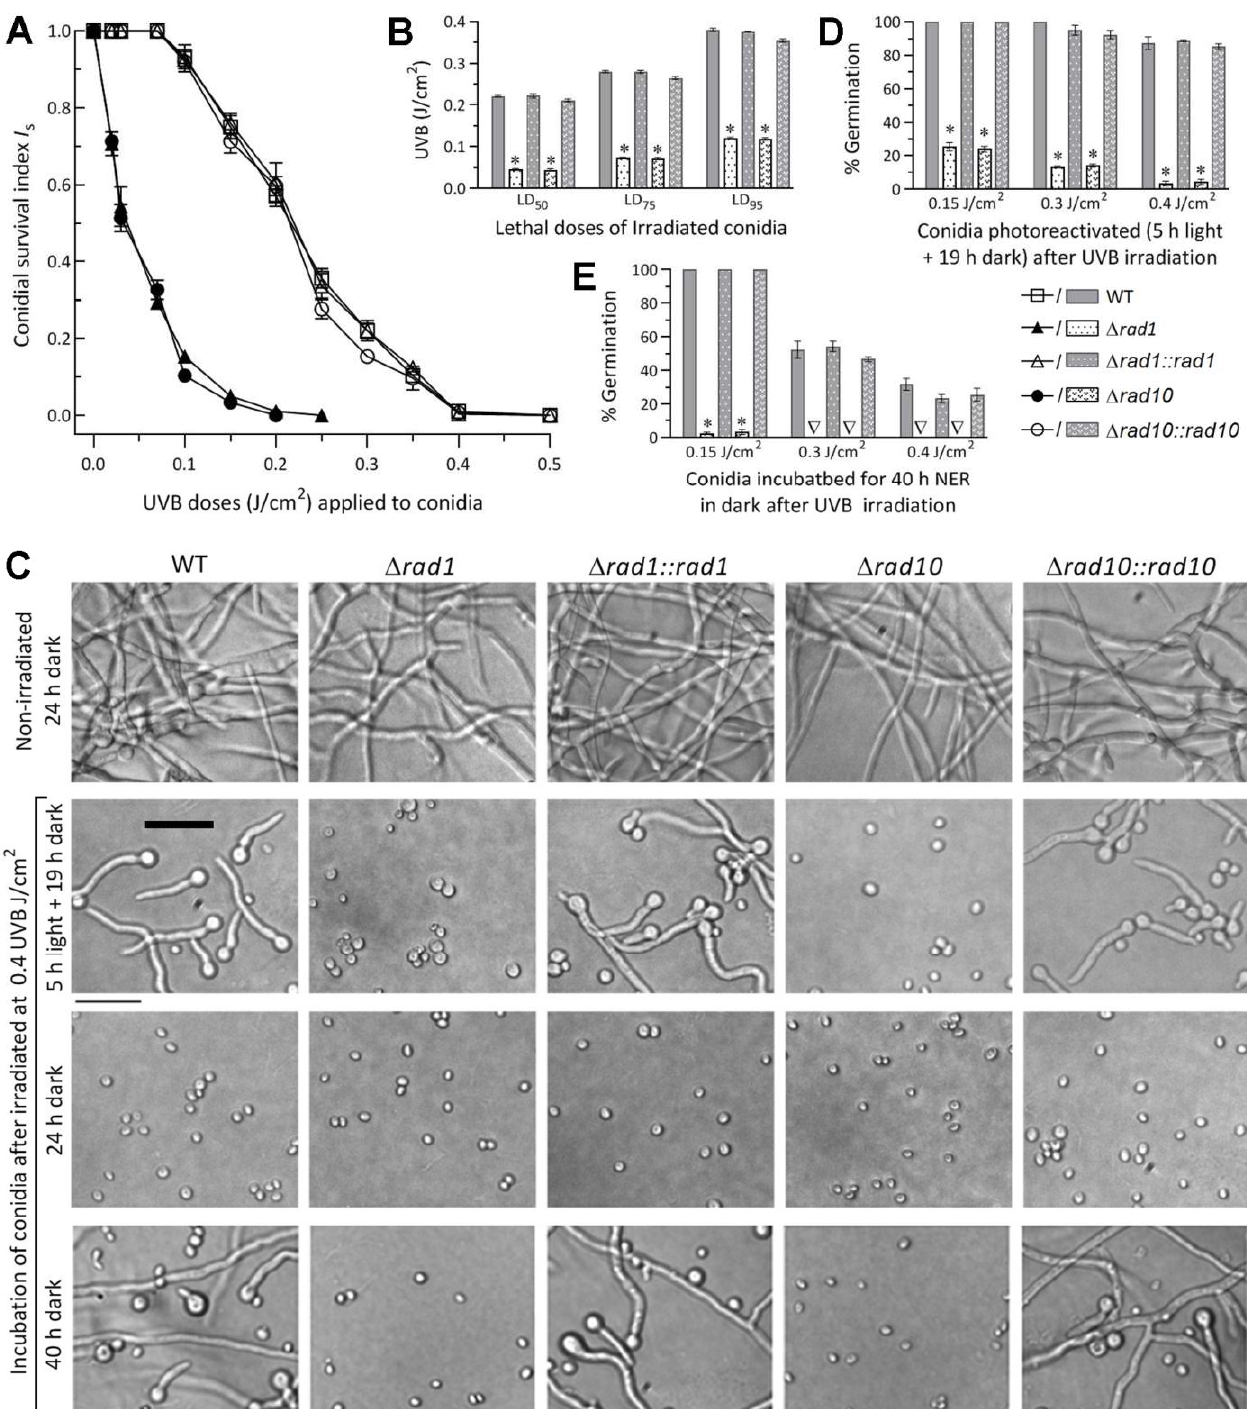
Figure 3. Essential roles of Rad1 and Rad10 in conidial resistance to UVB damage and photoreactivation of UBV-impaired conidia in B. bassiana . ( A ) Conidial survival trends of ∆ rad1 , ∆ rad10 , and their control strains over the gradient UVB doses. ( B ) LD 50 , LD 75 , and LD 95 estimated as indices of conidial UVB resistance by modeling analyses of tested strains’ survival trends. ( C – E ) Microscopic images (scale: 20 μm) for germination status and germination percentages of the tested strains’ conidia during an incubation at 25 °C of 5 h under white light plus 19 h in full dark (photoreactivation) or of 40 h in the dark (NER) after they were impaired differentially at the indicated UVB doses. * p < 0.0001 in Tukey’s HSD tests. Error bars: SDs from three independent replicates.